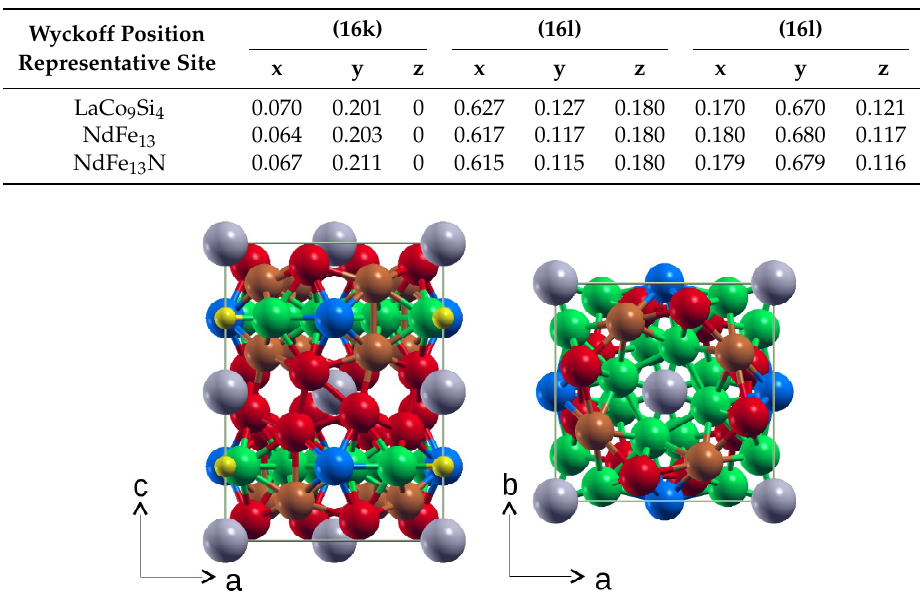
Figure 1. (Color online) Structure model of the NdFe 13 X (1-13-X) phases. Large grey spheres represent Nd atoms and small yellow spheres represent interstitial atoms X = B, C, or N. The Fe atoms are shown as spheres of medium size in red, blue, brown, and green, corresponding to the four Wyckoff positions. The structure model of NdFe 13 (1-13) looks very similar due to the little deviations in lattice and internal parameters but of course the (4c) Wyckoff positions remain